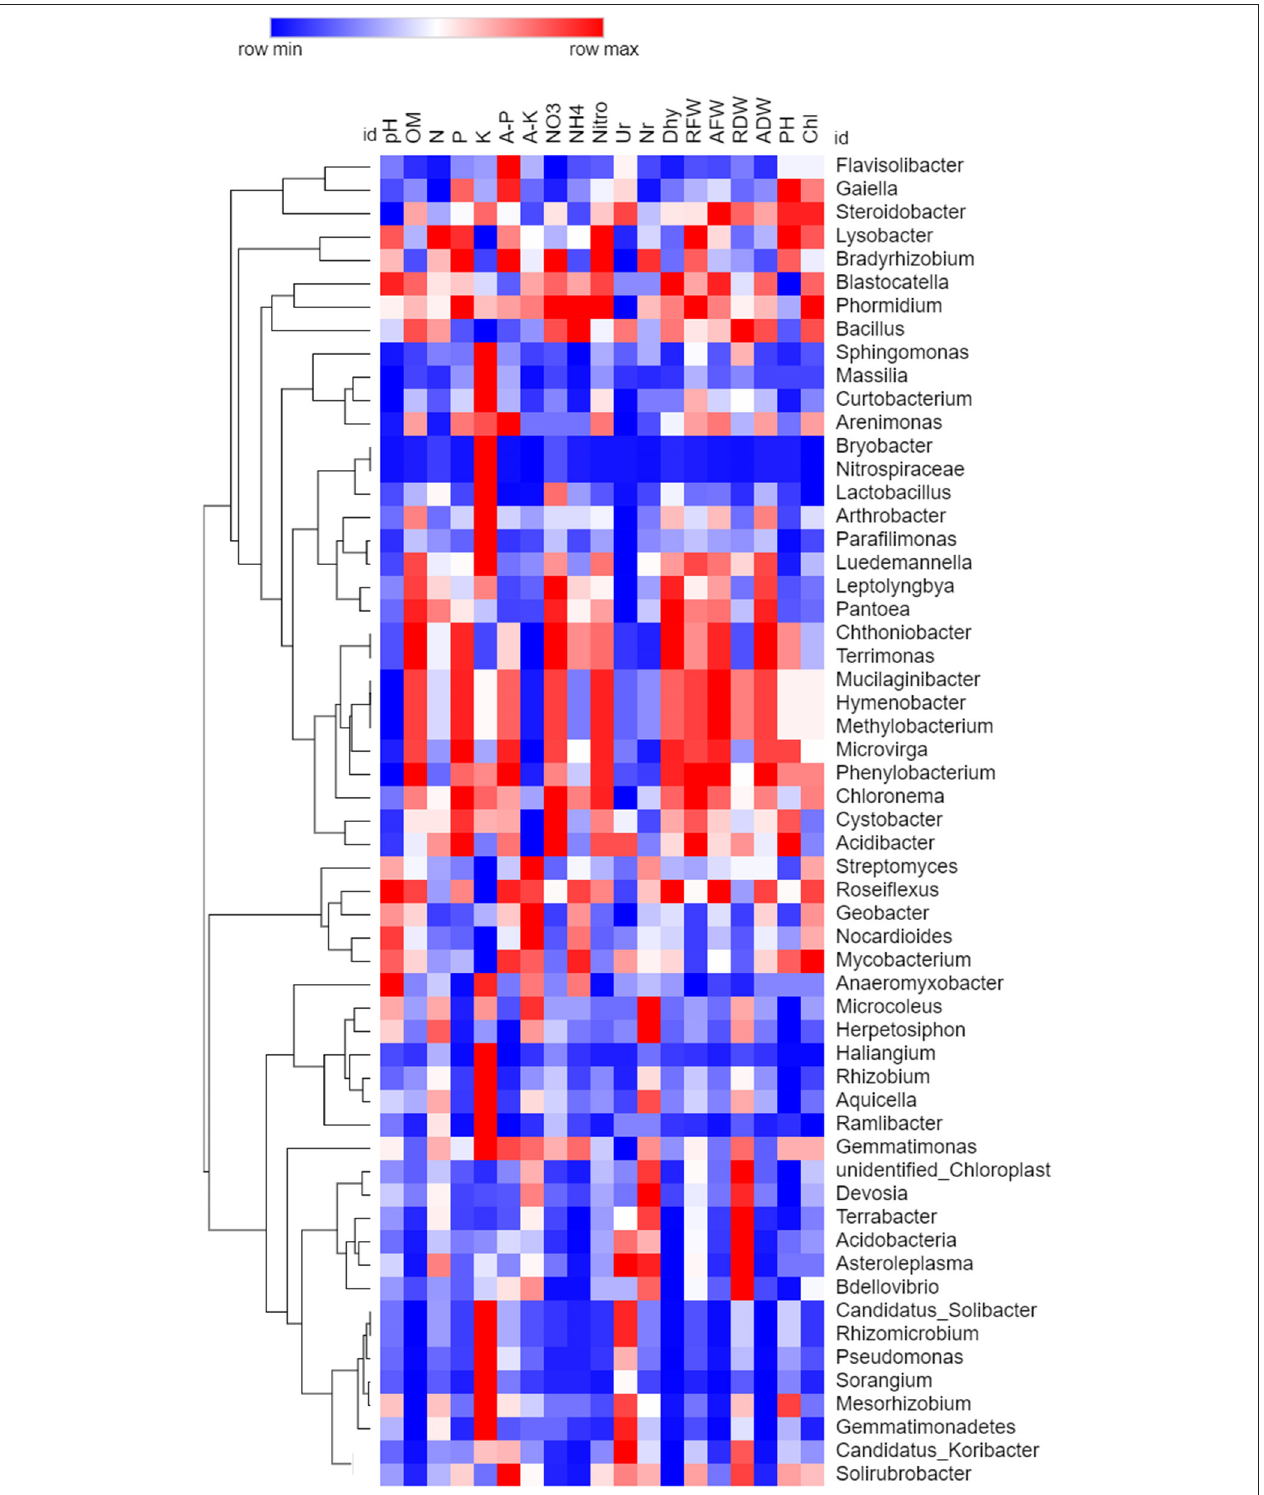
FIGURE 10 | Spearman’s rank correlation analysis between soil chemical properties, soil enzymes, and plant growth parameters with bacterial communities. The heat map is drawn based on P -value (Higher to minimum p -value indicated through red to blue color, respectively).